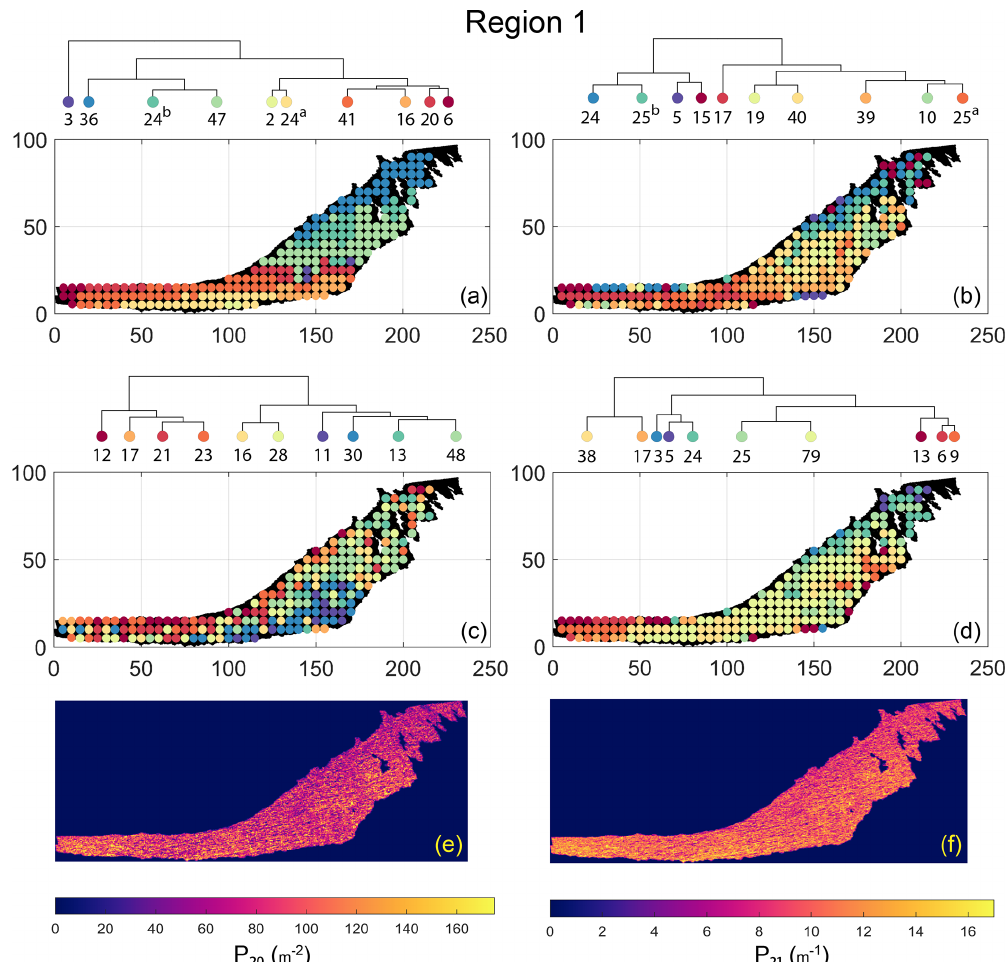
Figure 17. Hierarchical clustering results for Region 1 depicting the top 10 clusters using (a) fingerprint distance, (b) D-measure distance, (c) NetLSD distance, (d) portrait divergence distance, (e) spatial P 20 , and (f) spatial P 21 . Table 5. Summary of subgraphs within each cluster of Region 2 for k =